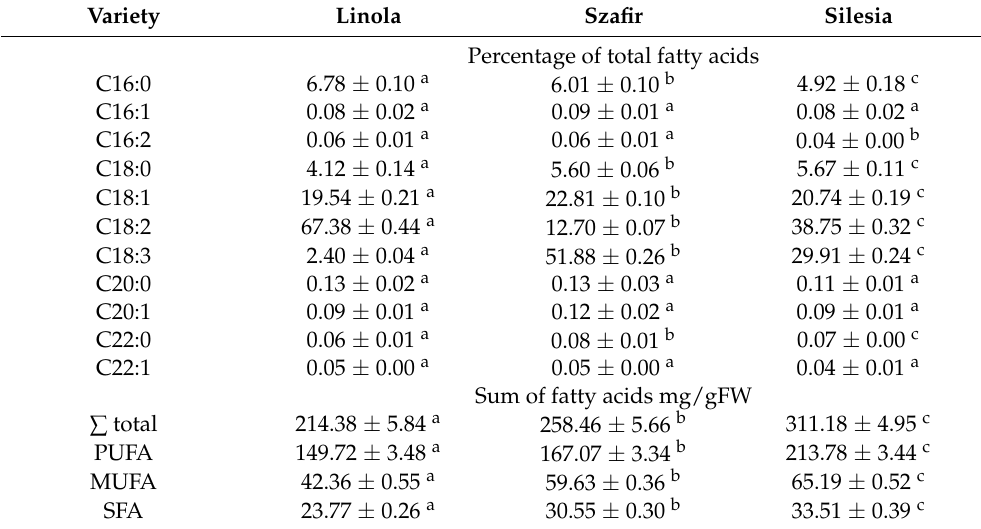
Table 5. Fatty acid composition in oil. FW—fresh weight of seeds. All results are statistically significant ( p < 0.05). Different superscripts imply significant differences. Variety Linola Szafir Silesia Percentage of total fatty